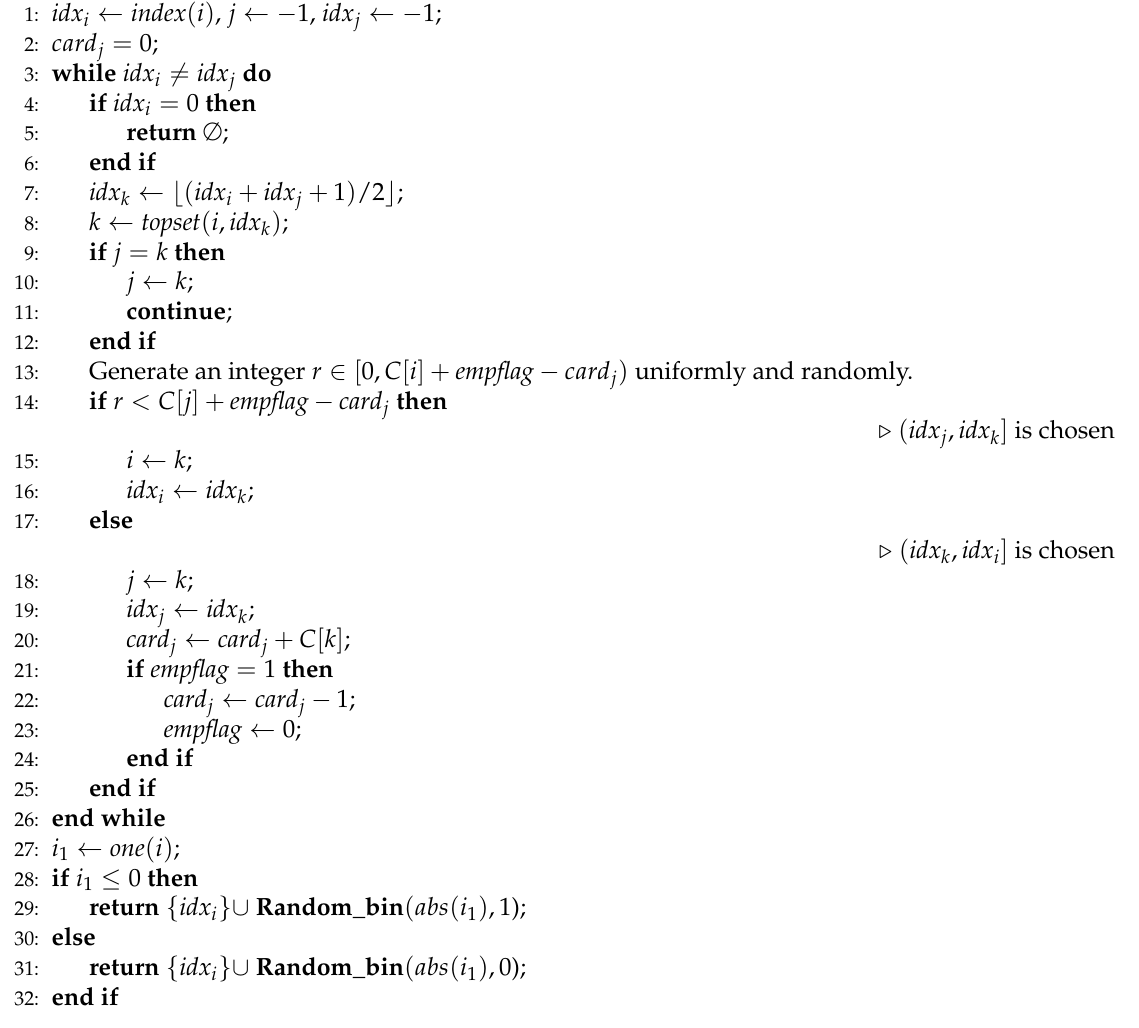
Algorithm 6 Random_bin ( i , empflag ) : Algorithm that returns a set uniformly and randomly chosen from the family of sets represented by the ZDD whose root is node i . This algorithm chooses the index by binary search on nodes linked by